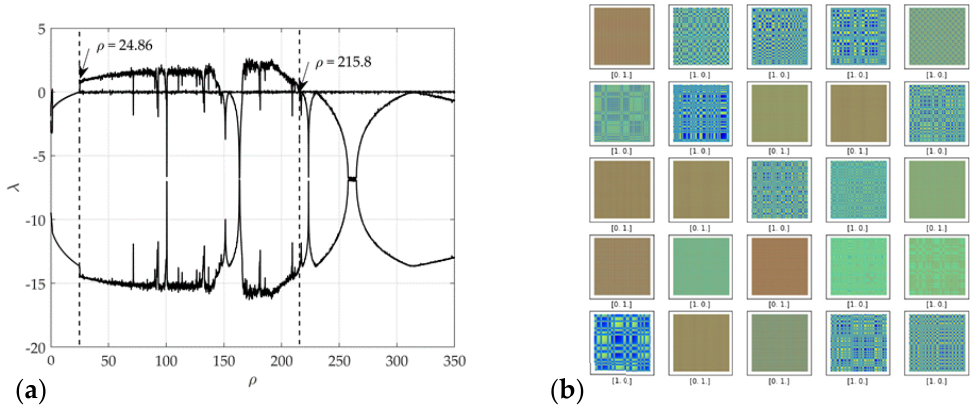
Figure 5. Dataset labeling with respect to the chaotic signal, ( a ) Lyapunov exponent in the range 0 < ρ < 350, ( b ) recurrence